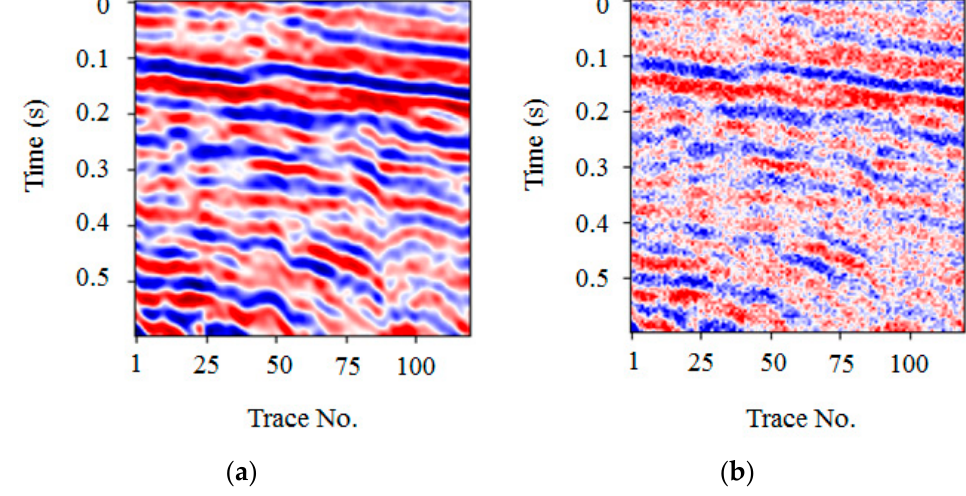
Figure 5. Synthetic seismic signal example. ( a ) Clean data, ( b ) Noise data (PSNR = 13.98 dB).